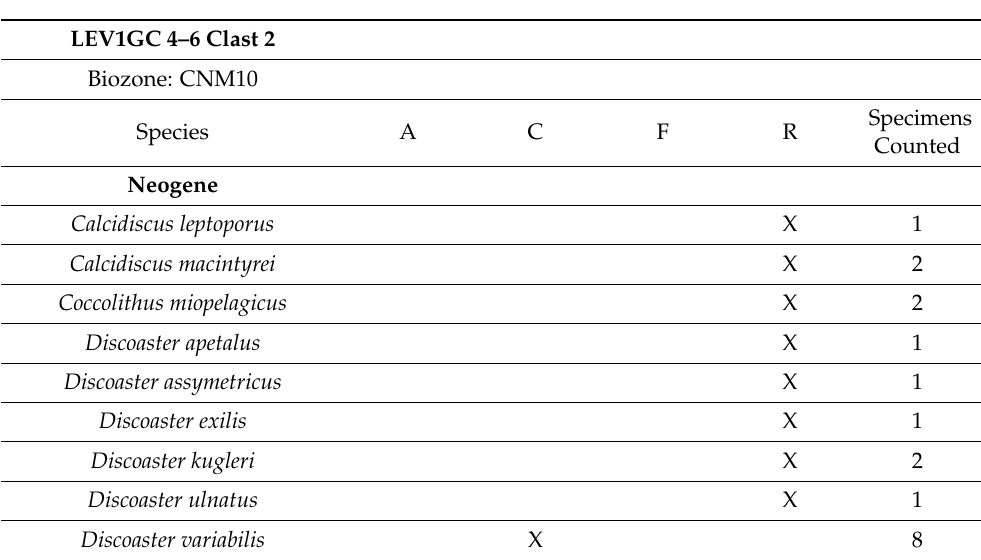
Table A8. Gelendzhik